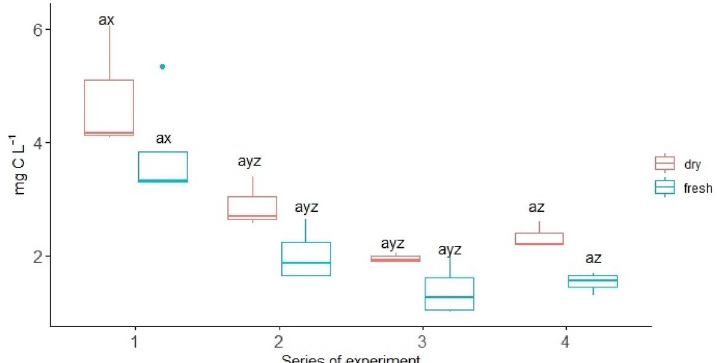
Figure 1. The change of total root-exuded carbon (mg C L −1 ) over time depending on the moisture variant; different lowercase letters (a,b) indicate significant differences in parameters between the different moistures; different lowercase letters (x,y,z) indicate significant differences in parameters between the series; Tukey HSD p < 0.05 .